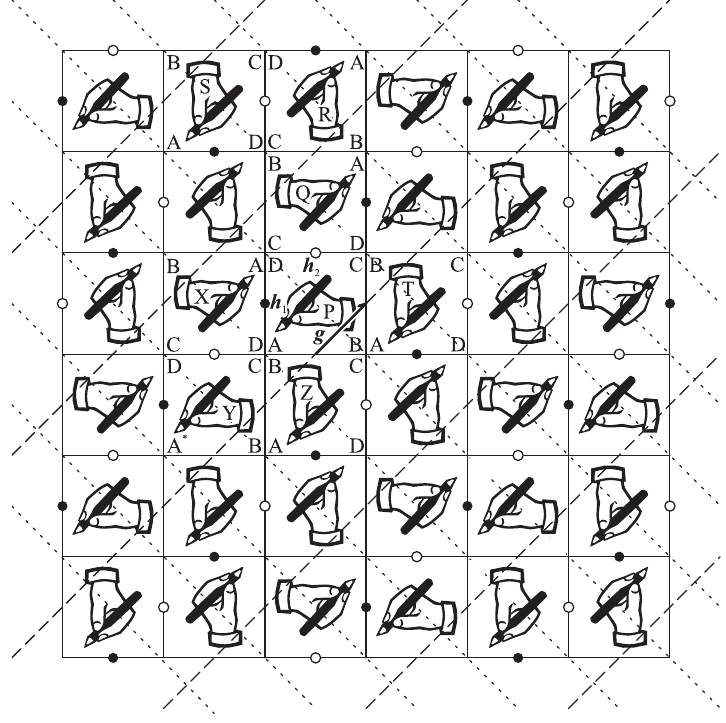
Figure 2. Fundamental tiling by crystallographic group